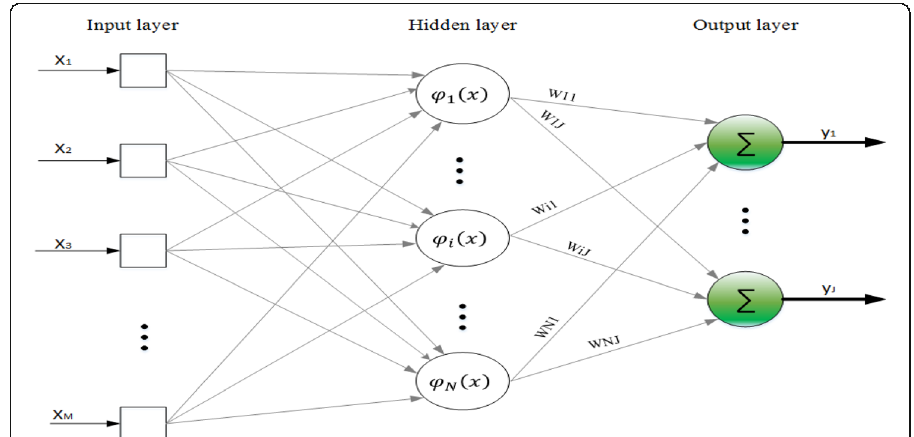
Fig. 3 Typical structure of the